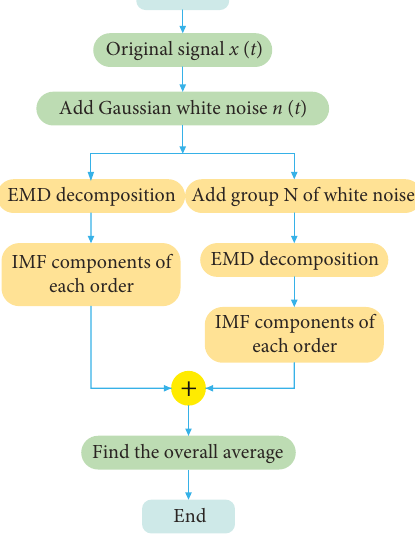
Figure 2: EEMD decomposition flow chart.